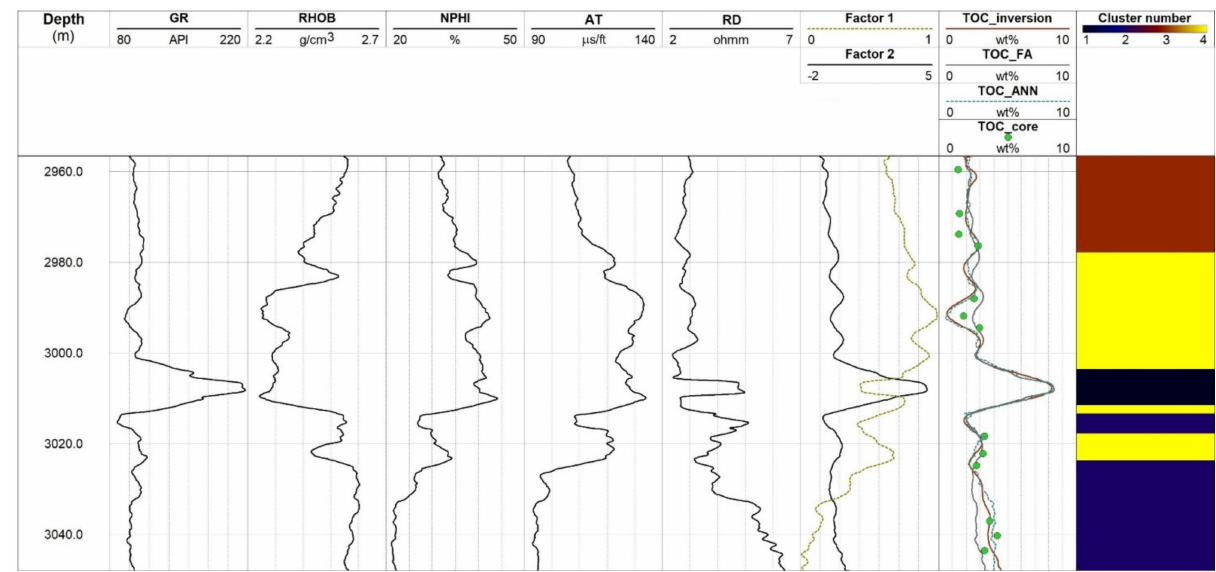
Figure 4. Result of factor analysis in Well B. Denotations are as follows: natural gamma-ray (GR), bulk density (RHOB), neutron porosity (NPHI), sonic travel-time (AT), deep induction resistivity (RD), first factor (Factor 1), second factor (Factor 2), TOC estimates from interval inversion (TOC_inversion), TOC estimates from the factor analysis (TOC_FA) and TOC estimates of artificial neural network (TOC_ANN). The last track shows the depth distribution of four identified clusters.